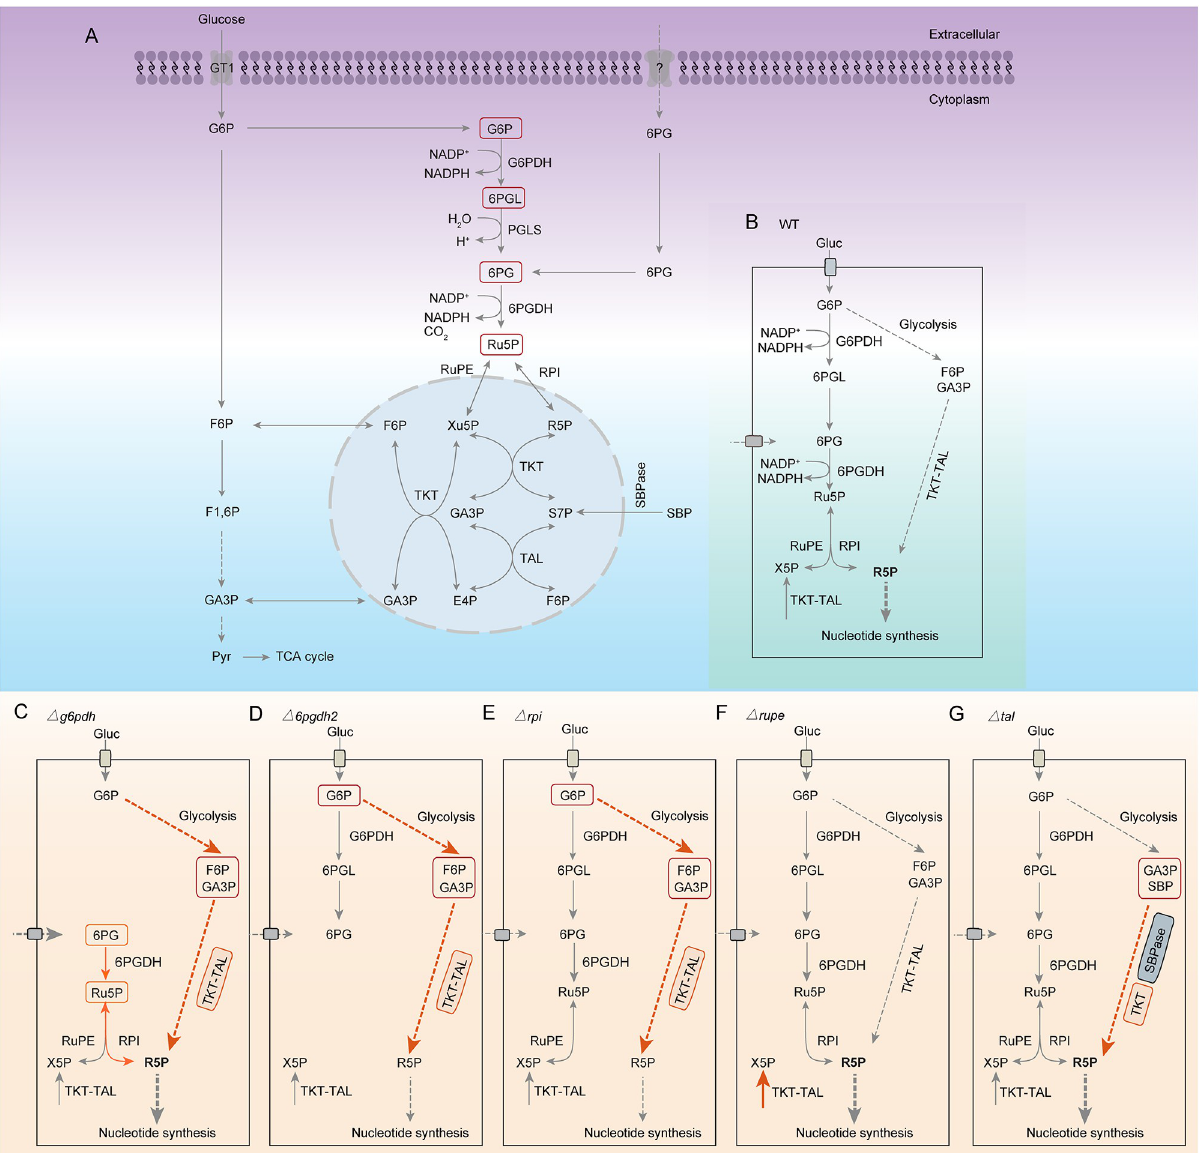
Fig 8. Proposed models for PPP metabolism under various conditions. (A-B) , Parasites can generate ribose-5-phosphate using the oxidative pentose phosphate pathway ( Tg G6PDH- Tg 6PGDH2- Tg RPI pathway) and non-oxidative pentose phosphate pathway ( Tg TKT- Tg TAL pathway). (C) , Upon disruption of Tg G6PDH, Tg G6PDH-dependent pentose synthesis is blocked but ribose-5-phosphate is still produced by the intact downstream oxidative pentose phosphate pathway ( Tg 6PGDH2- Tg RPI pathway) which might utilize host-derived PPP intermediates. (D) , In Δ 6pgdh2 mutants, glucose imported from host cells cannot be fully catabolized to create ribose-5-phosphate. Even so, ribose-5-phosphate was still partly produced through the Tg TKT- Tg TAL pathway. (E) , Similar to Δ 6pgdh2 mutants, the Δ rpi mutants also partly produced ribose-5-phosphate through the Tg TKT- Tg TAL pathway. (F) , Mutants lacking Tg RuPE rely on the Tg TKT- Tg TAL pathway for supplying Xylulose 5P. Notably, the ribose-5-phosphate can be generally provided by the oxidative and non-oxidative pentose phosphate pathway. (G) , In Δ tal mutants, the ribose-5-phosphate can be provided through the oxidative pentose phosphate pathway and Tg TKT- Tg SBPase